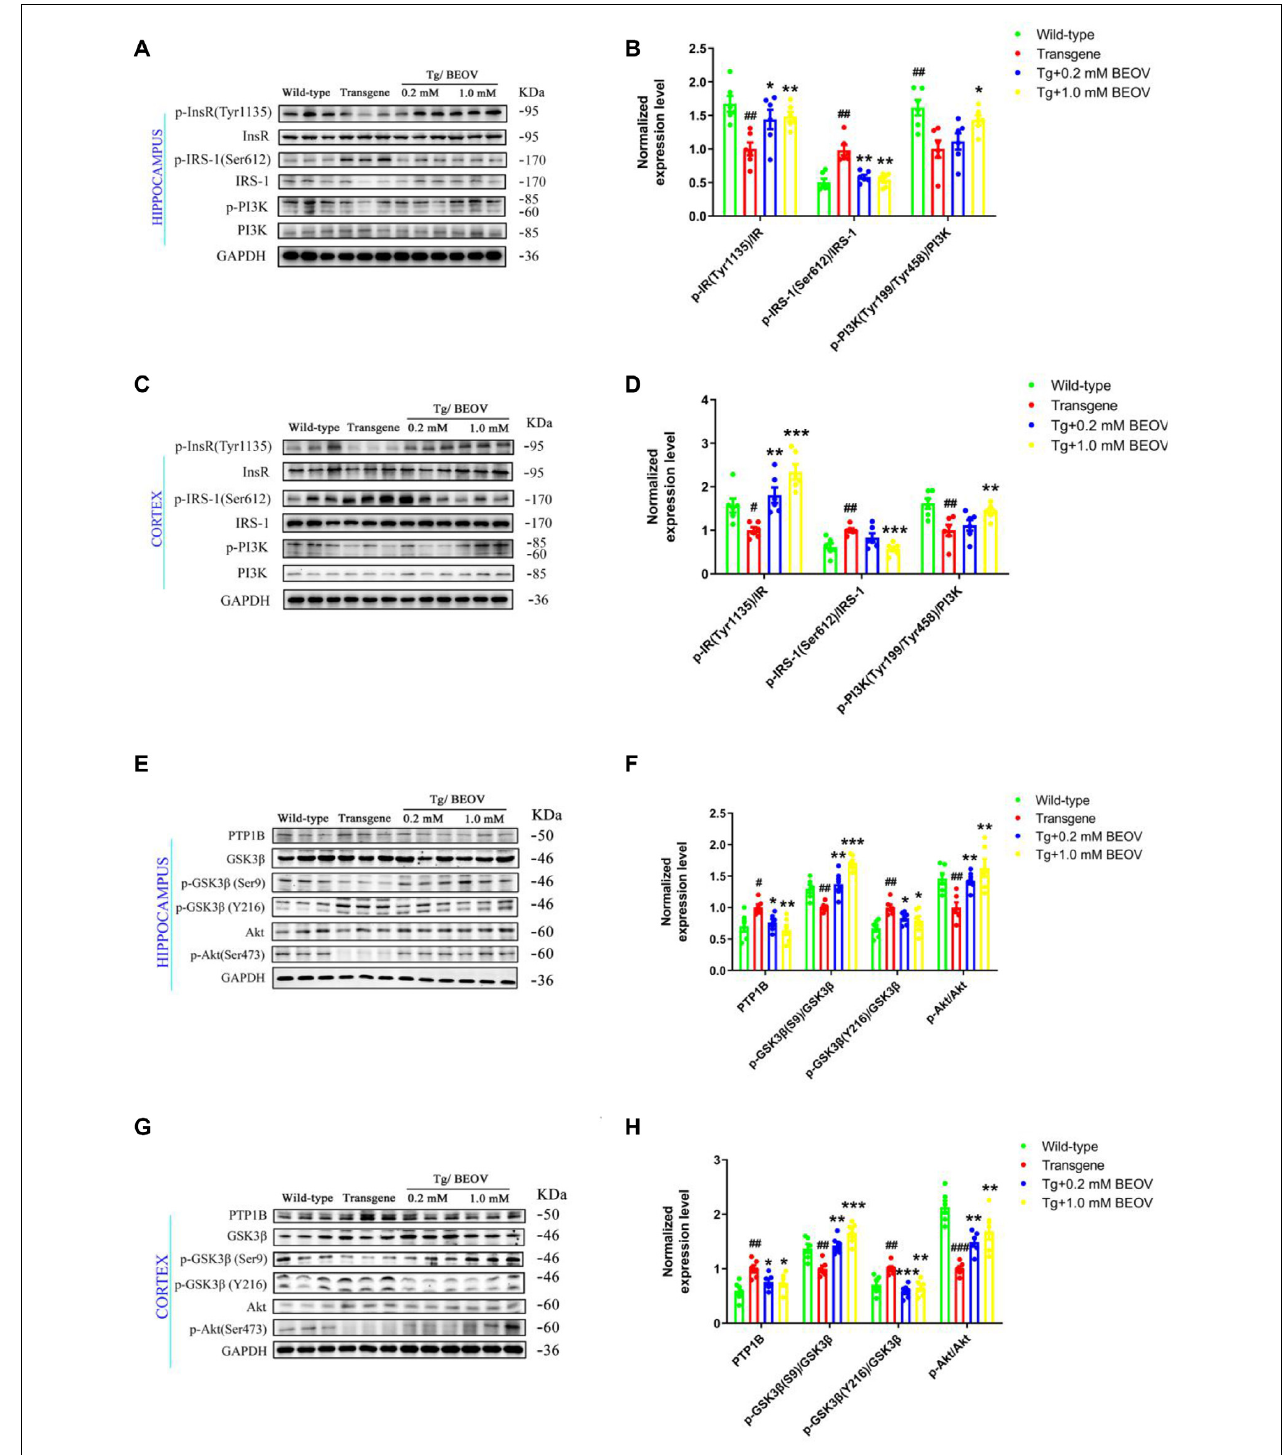
FIGURE 8 | Effect of BEOV on PTP1B activity, insulin signaling and tau hyperphosphorylation in APPswe/PS1dE9 mice. (A,C,E,G) Western blotting analyses of several key proteins involved in the pathway of tau phosphorylation in mouse hippocampus and cortex. (B,D,F,H) Semi-quantification of PTP1B, the relative ratio of p-IR/IR, p-IRS-1/IRS-1, p-PI3K/PI3K, pS9-GSK3 β /GSK3 β , pY216-GSK3 β /GSK3 β , and p-Akt/Akt in the hippocampus and cortex of WT, APPSwe/PS1dE9, and BEOV-treated APPSwe/PS1dE9 mice. Quantitative results were normalized against the levels of GAPDH. # WT group vs. AD group; *AD + BEOV group vs. AD group. n = 6, three females and three males; # P < 0.05, ## P < 0.01, ### P < 0.001, * P < 0.05, ** P < 0.01, and *** P < 0.001, respectively.